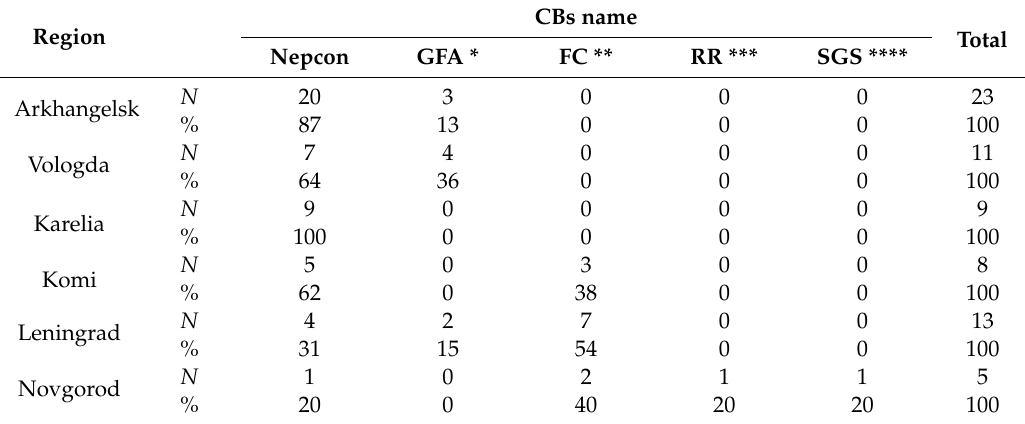
Table 8. Certificates issued by certification